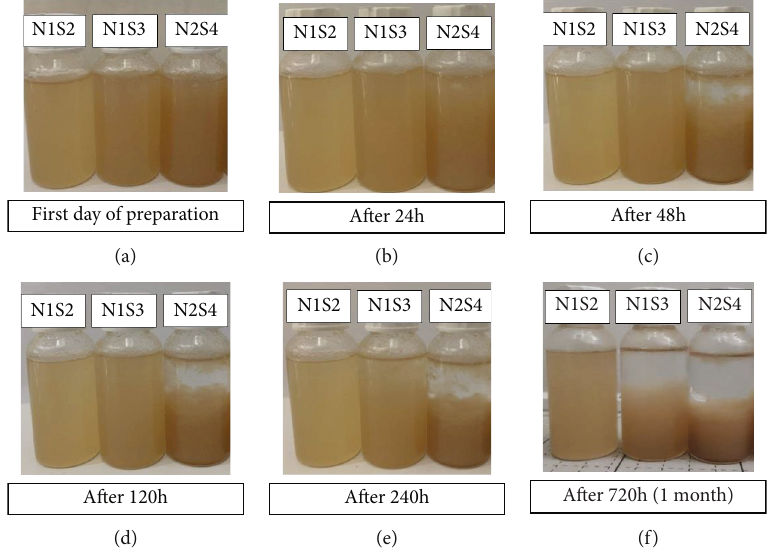
Figure 5: Stability observation of biolubricants at particular